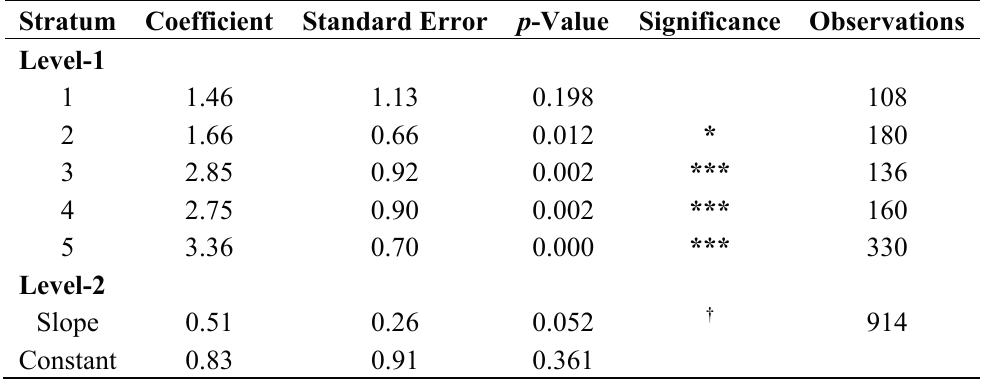
Table 5. Relationship between Peer-Drinking and Youth-Drinking under Heterogeneity Assumption.